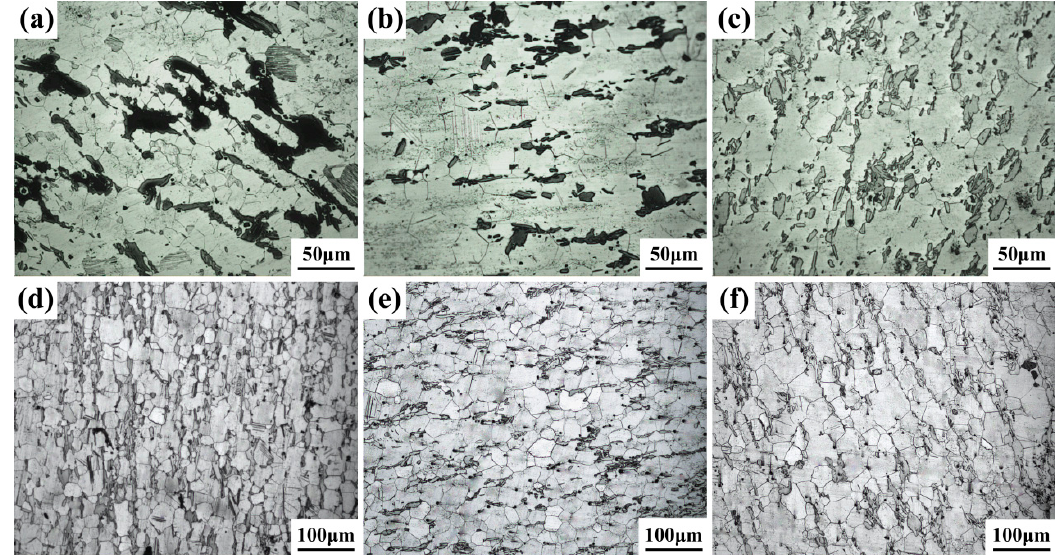
Figure 2. SEM photo and XRD results. ( a ) SEM photo of the deformed alloy. ( b ) XRD results of the deformed and 510 °C × 13 h solution-treated alloys.